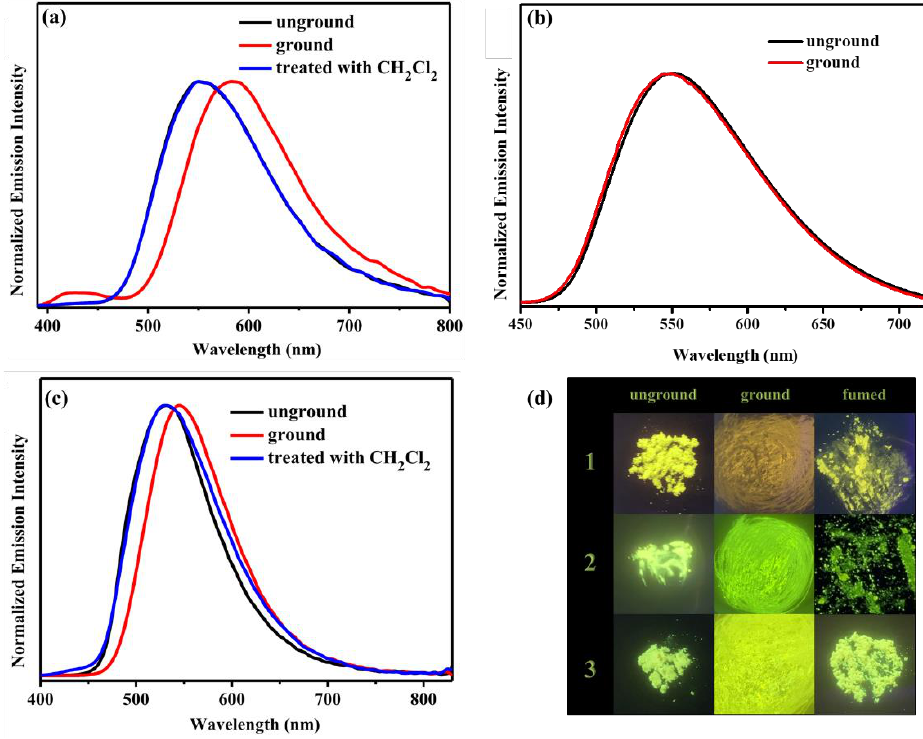
Figure 4. FL spectra of compounds 1 ( a ), 2 ( b ), and 3 ( c ) in various solid states. ( d ) FL photographs of compounds 1 – 3 in various solid states under 365 nm UV light.